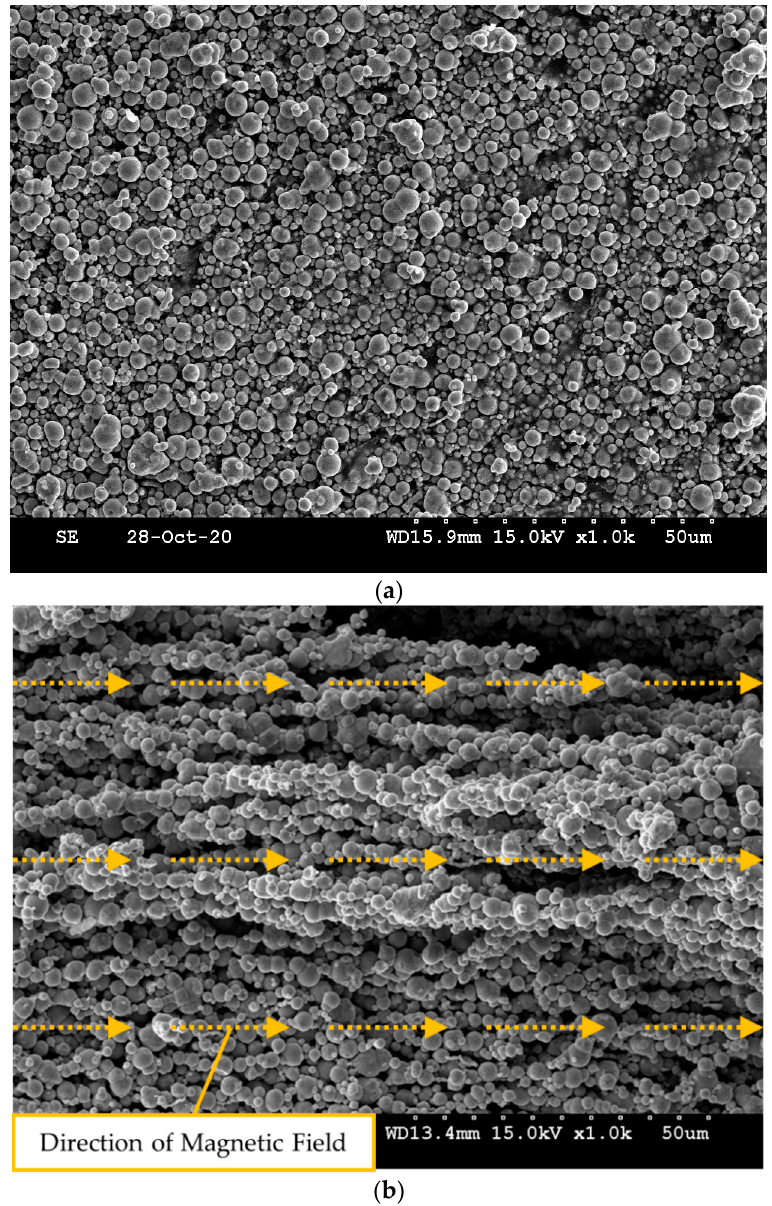
Figure 5. CIPs distribution of MRE (×1000): ( a ) magnetic field OFF, ( b ) magnetic field ON (0.2 T). To measure the MR effect of the manufactured MRE, the storage modulus and loss factor are measured using an MCR 302 rheometer (Anton Paar, Graz, Austria). Figure 6 presents the measured results for the modulus values. As well known, the storage modulus represents the elasticity, while the loss modulus represents the viscosity. The